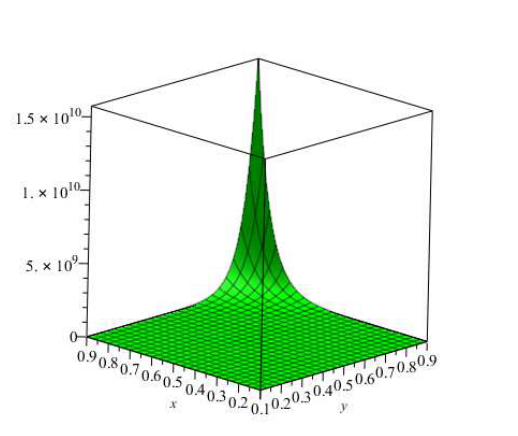
Figure 2: Graphical Representation of M-polynomial of hex-derive network HDN 1( n